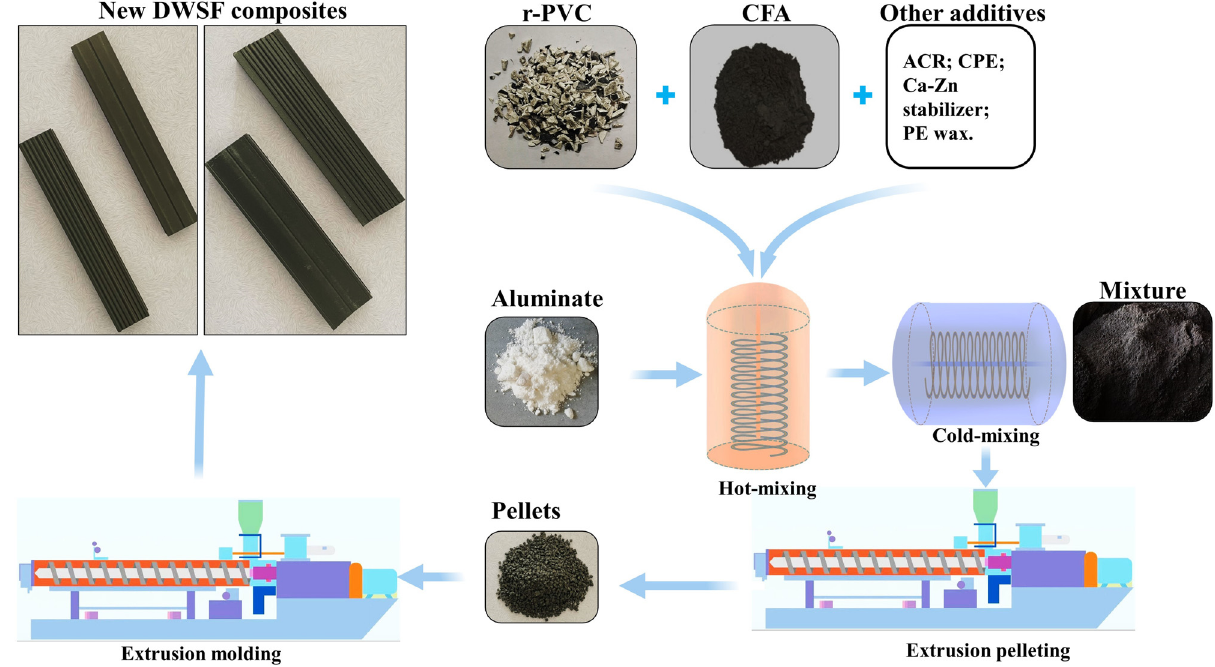
Figure 1: Process fl ow diagram of the preparation of CFA - based new DWSF composites.